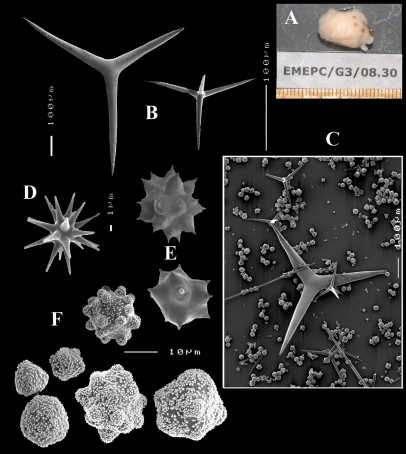
Calthropella (Calthropella) durissima, specimen EMEPC/G3/08.30, from S of Azores, Atlantis Seamount A habit B ‘tripod’ and calthrops C overview of spicules D oxyaster E smooth spheroxyasters F tuberculated spheraster and various derived slica bodies.